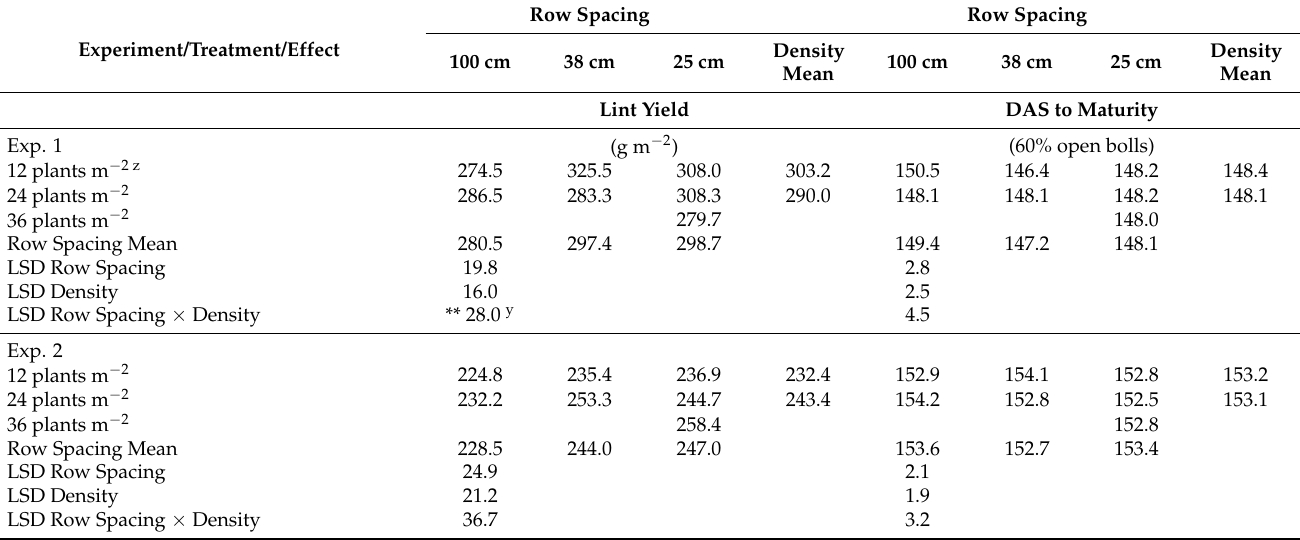
Table 4. Yield and days after sowing (DAS) to maturity for Exps. 1 and 2 comparing inter and intra row plant density. LSDs are presented for comparison between plant densities, row spacing and the interaction between row spacing and plant